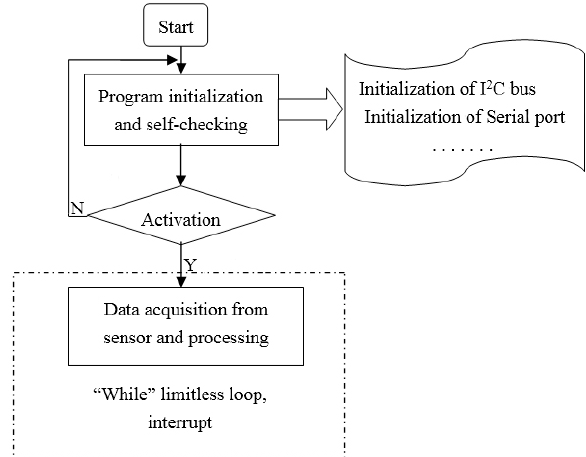
Figure 7. Flow chart of the main program.